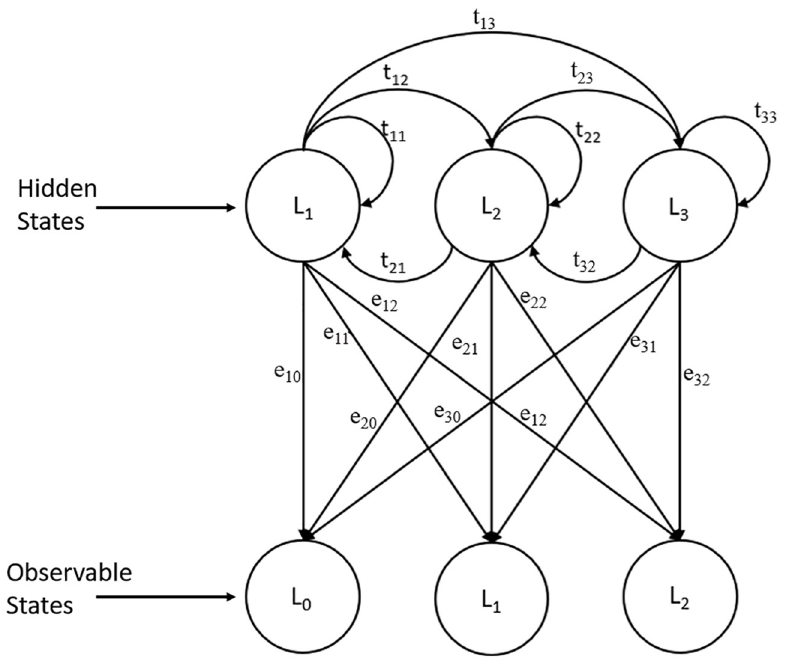
Fig 12. First HMM represented by